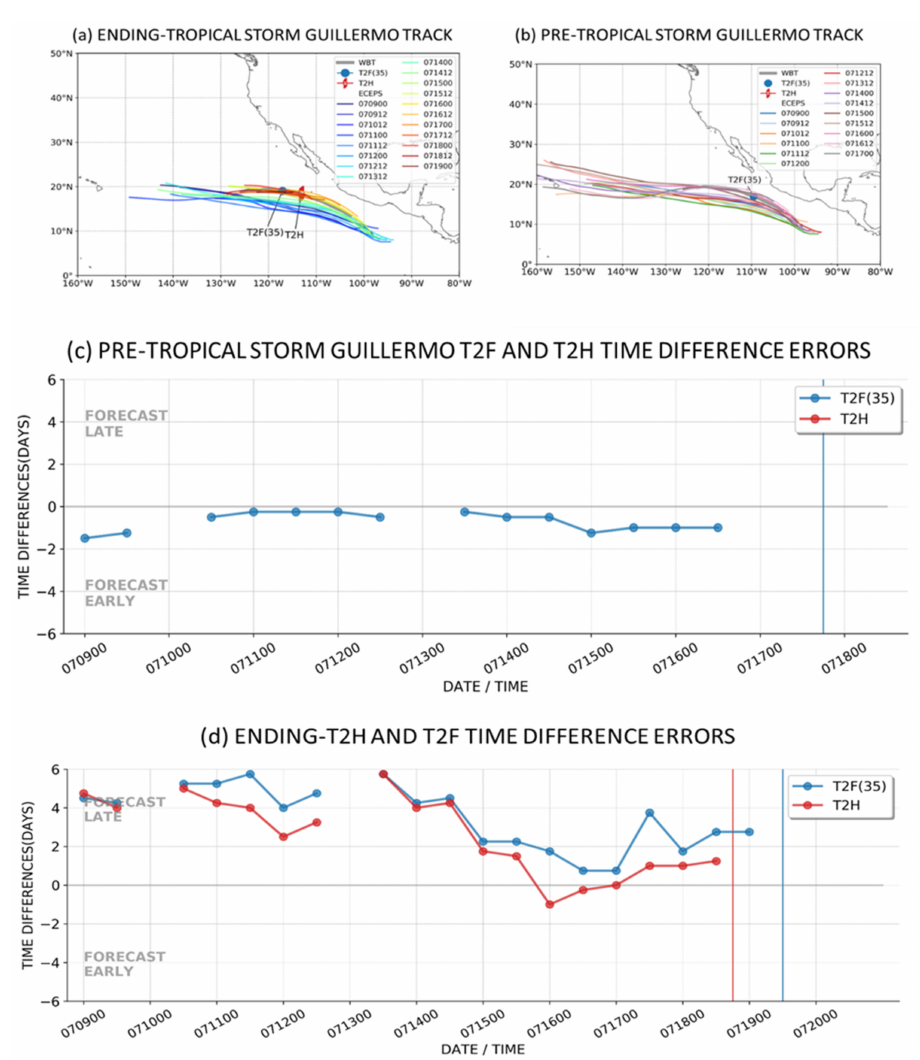
Figure 19. Summary of the ECEPS pre-formation and ending-storm predictions as in Figure 4 except here for the Almost-Hurricane Guillermo